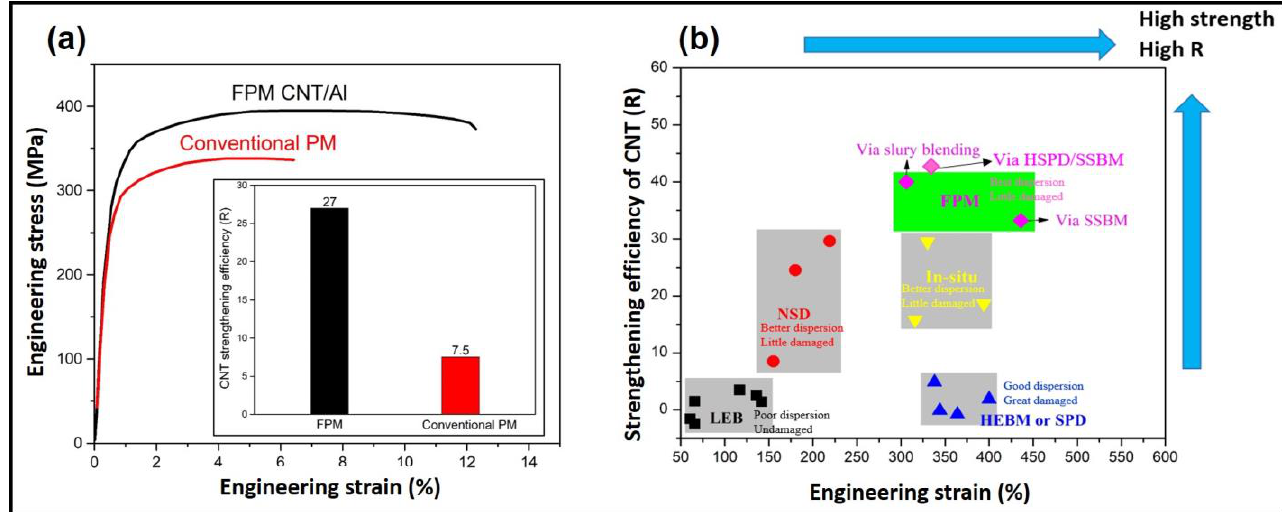
Figure 3. Tensile properties of CNT/Al nanocomposites ( a ) loading with 1 vol.% CNTs and fabricated by conventional PM and flake PM (inset shows the relevant strengthening efficiencies of CNTs), ( b ) The strengthening efficiency and tensile strength for CNT/Al composites fabricated by various methods, the data were drawn based on recent reviews [22,24,48,74,75].